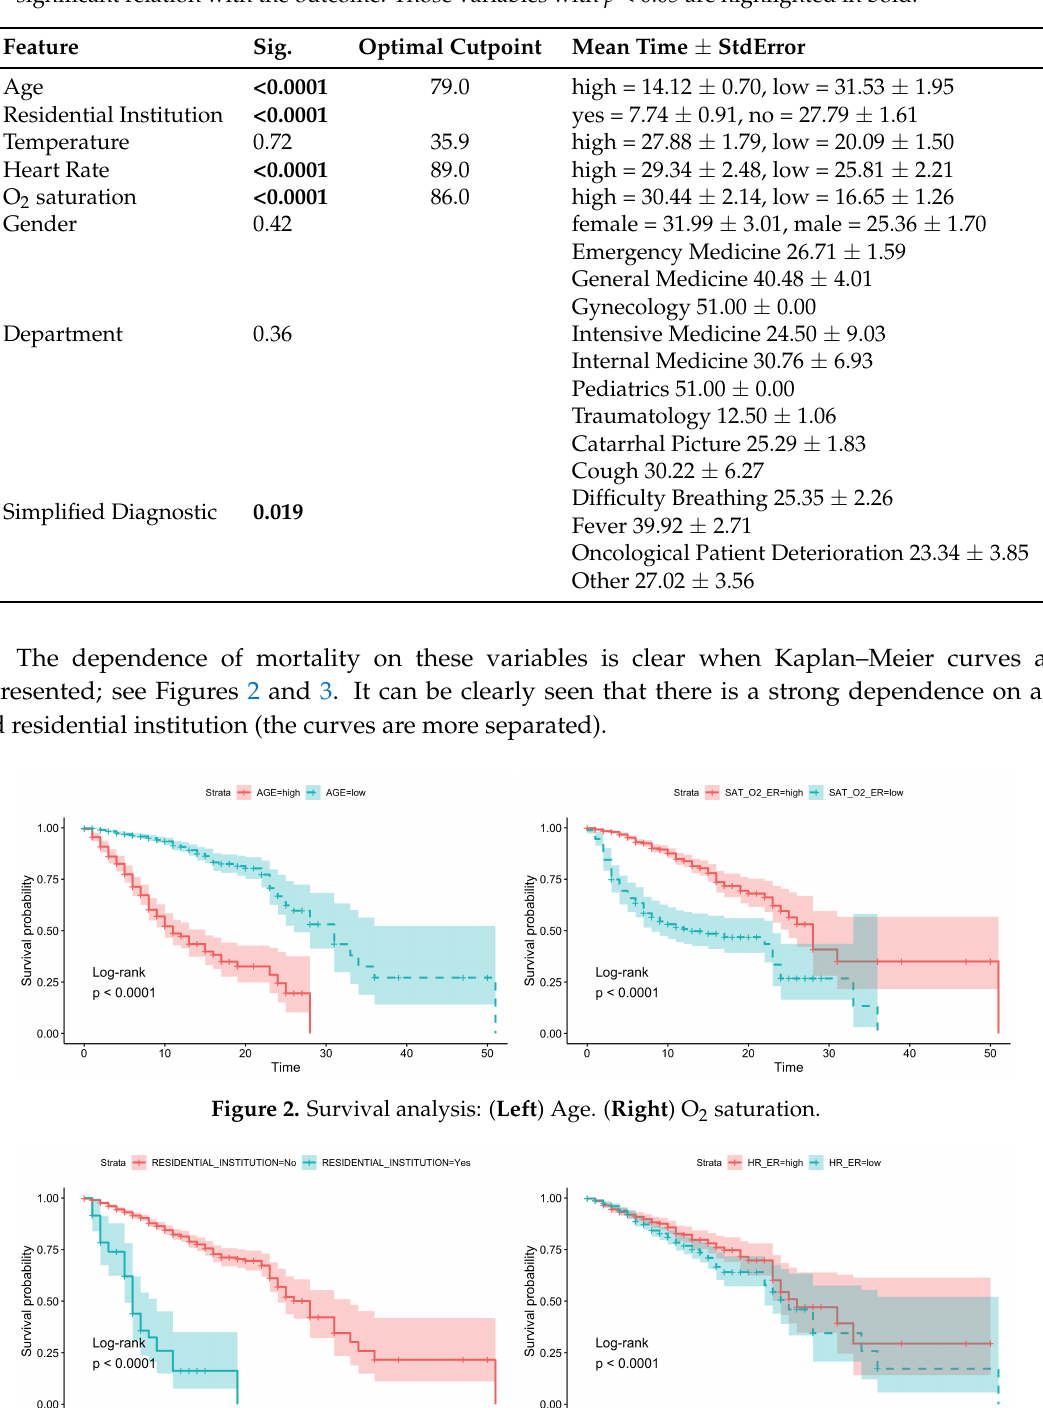
Table 1. Significant variables in the survival analysis. The continuous variables were discretized using the maximally selected rank statistics to provide a value of a cutpoint that corresponds to the most significant relation with the outcome. Those variables with p < 0.05 are highlighted in bold.